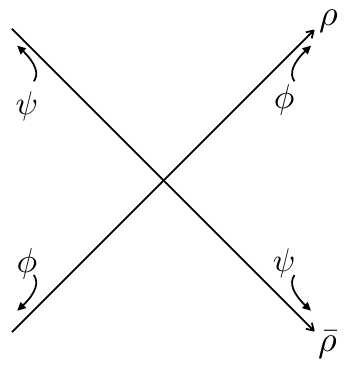
Figure 1 . The Regge limit is de(cid:12)ned by sending the four operators to null in(cid:12)nity while keeping the spacelike distance between the pairs of identical operators